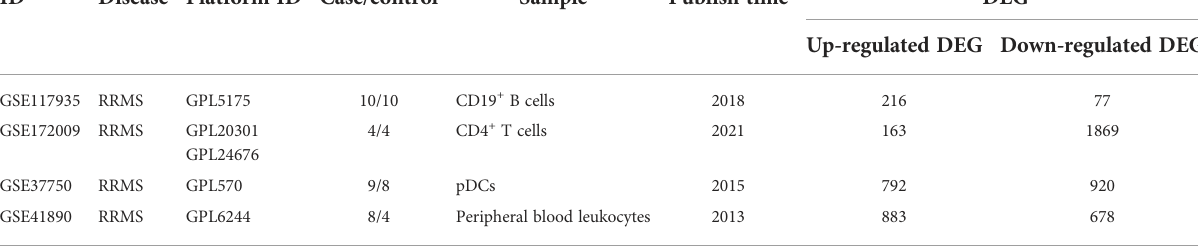
TABLE 1 Transcriptome datasets of MS patients without treatment. Disease Platform ID Case/control